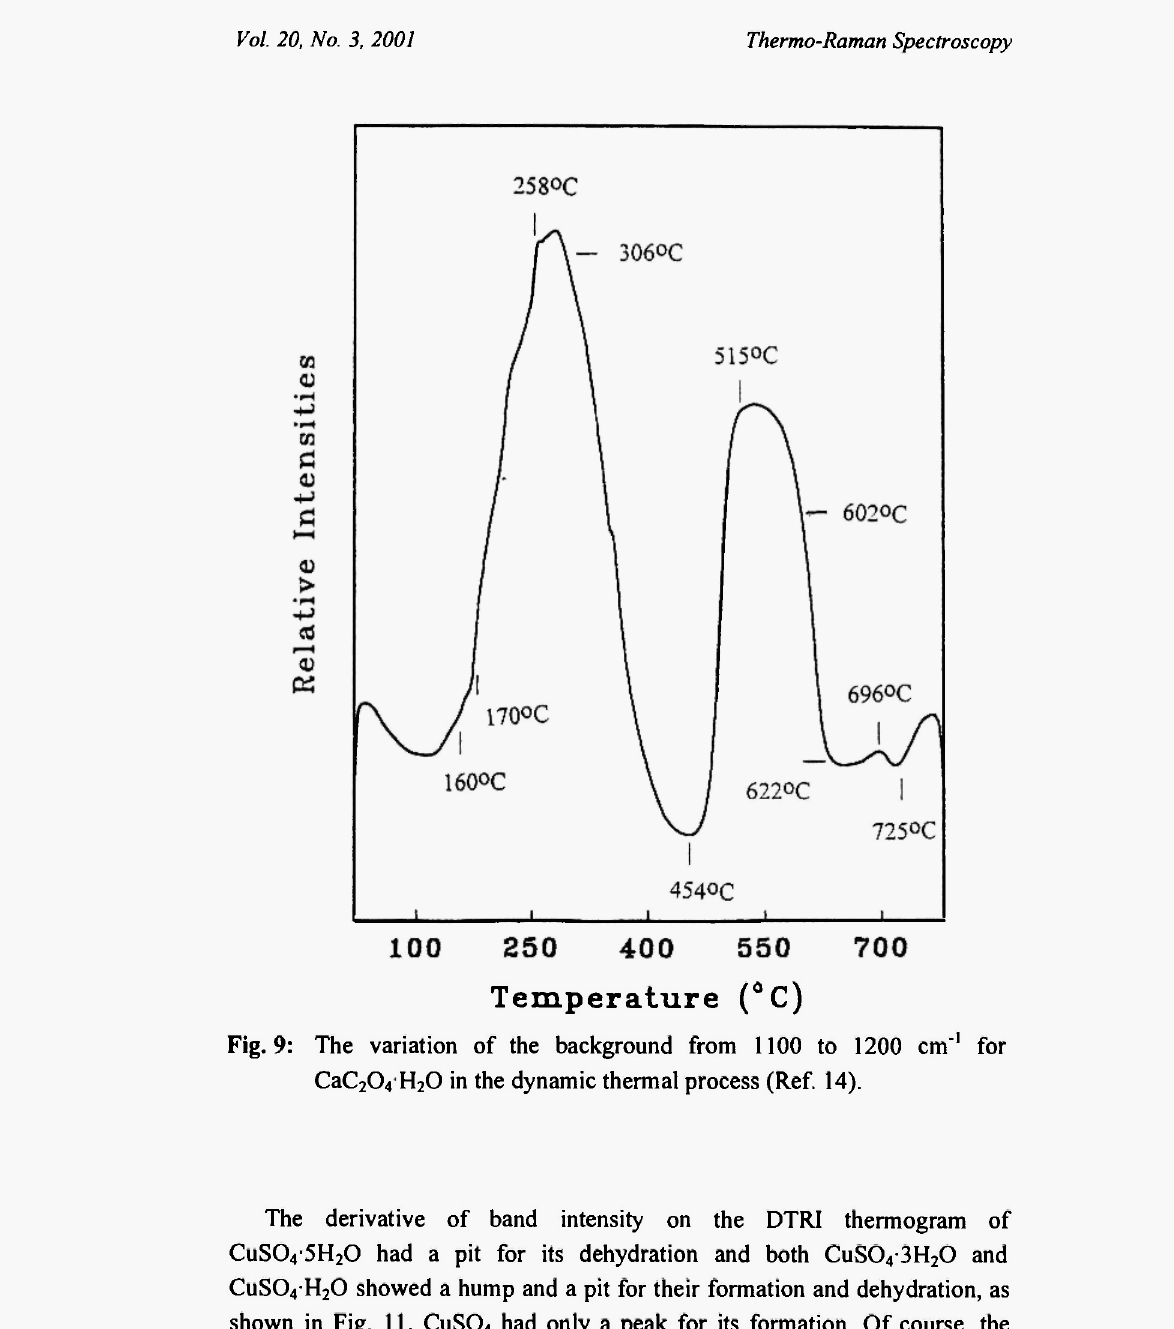
The derivative of band intensity on the DTRI thermogram of CuS0 4 -5H 2 0 had a pit for its dehydration and both CuS0 4 -3H 2 0 and CUS0 4 H 2 0 showed a hump and a pit for their formation and dehydration, as shown in Fig. 11. CuS0 4 had only a peak for its formation. Of course, the hump and the pit appeared around the same temperature. The band intensity around 3300 cm"' represented the amount of hydrated H 2 0 which was also measured. It resembled the TG thermogram as